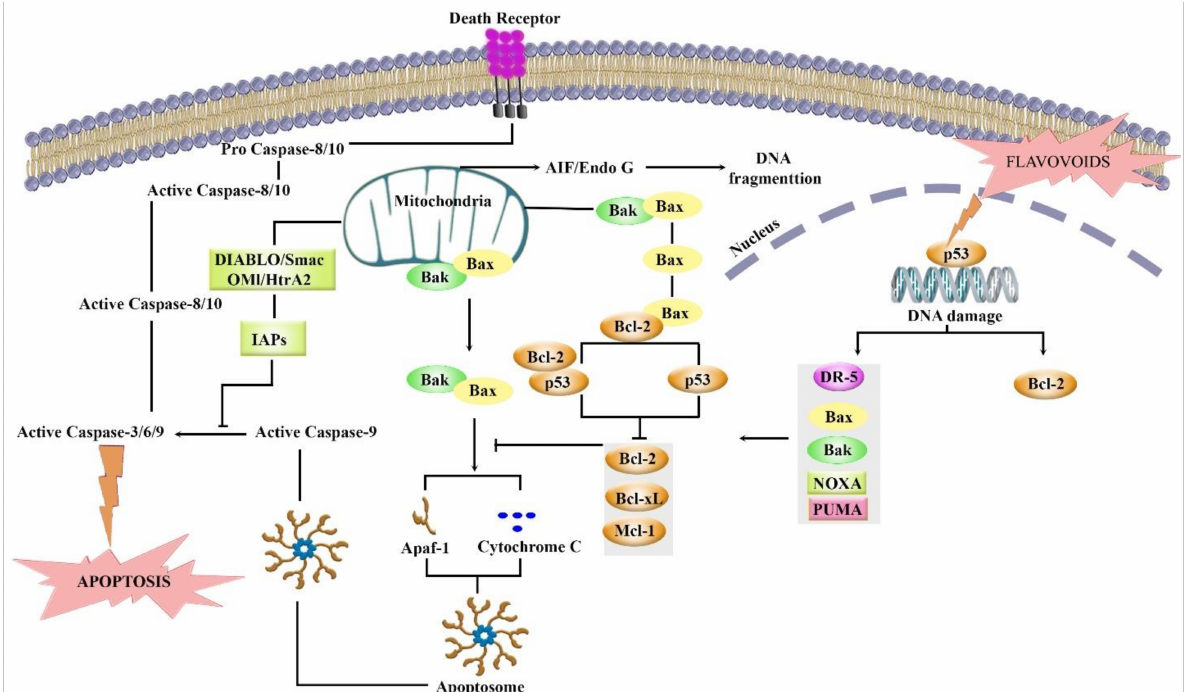
Figure 7. Targeting Bcl-2 in the p53 pathway by different flavonoids. It shows details of various events including up and downregulation, or expression that leads to